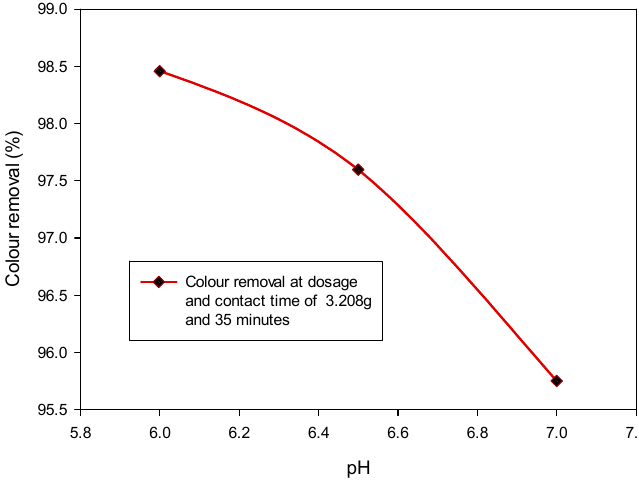
Figure 3. Colour removal from POME under variable pH at fixed sorbent dosage and contact time.